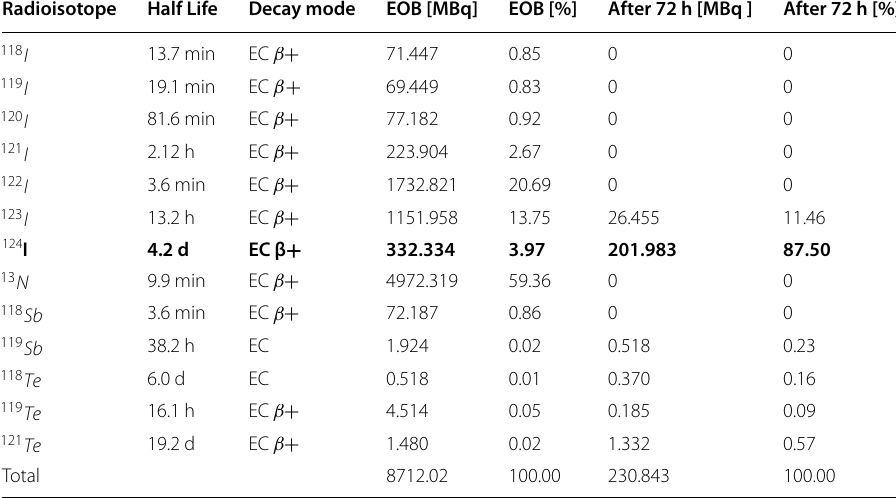
The production parameters: TeO 2 enriched in 124 Te, 18 MeV protons moderated to 14.8 MeV with 0.2 mm Havar, the proton current of 15 μA. The activity values at the end of bombardment (EOB) and the activity values after 72 hours since the end of bombardment are presented. 124 I is highlighted in bold